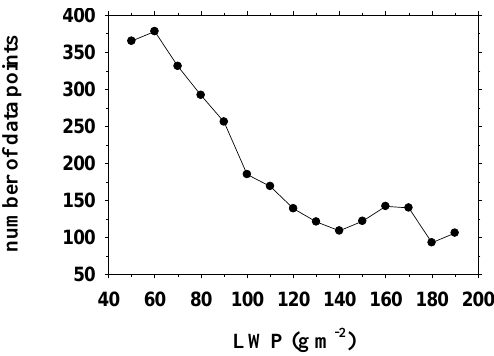
LWP (g m -2 ) Figure 2. Number of data points combining ground based in-situ measurement with satellite 2 Fig. 2. Number of data points combining ground based in-situ mea- cloud retrievals as a function liquid water path (LWP). LWP was derived from satellite 3 surement with satellite cloud retrievals as a function liquid water retrievals. 4 path (LWP). LWP was derived from satellite retrievals.